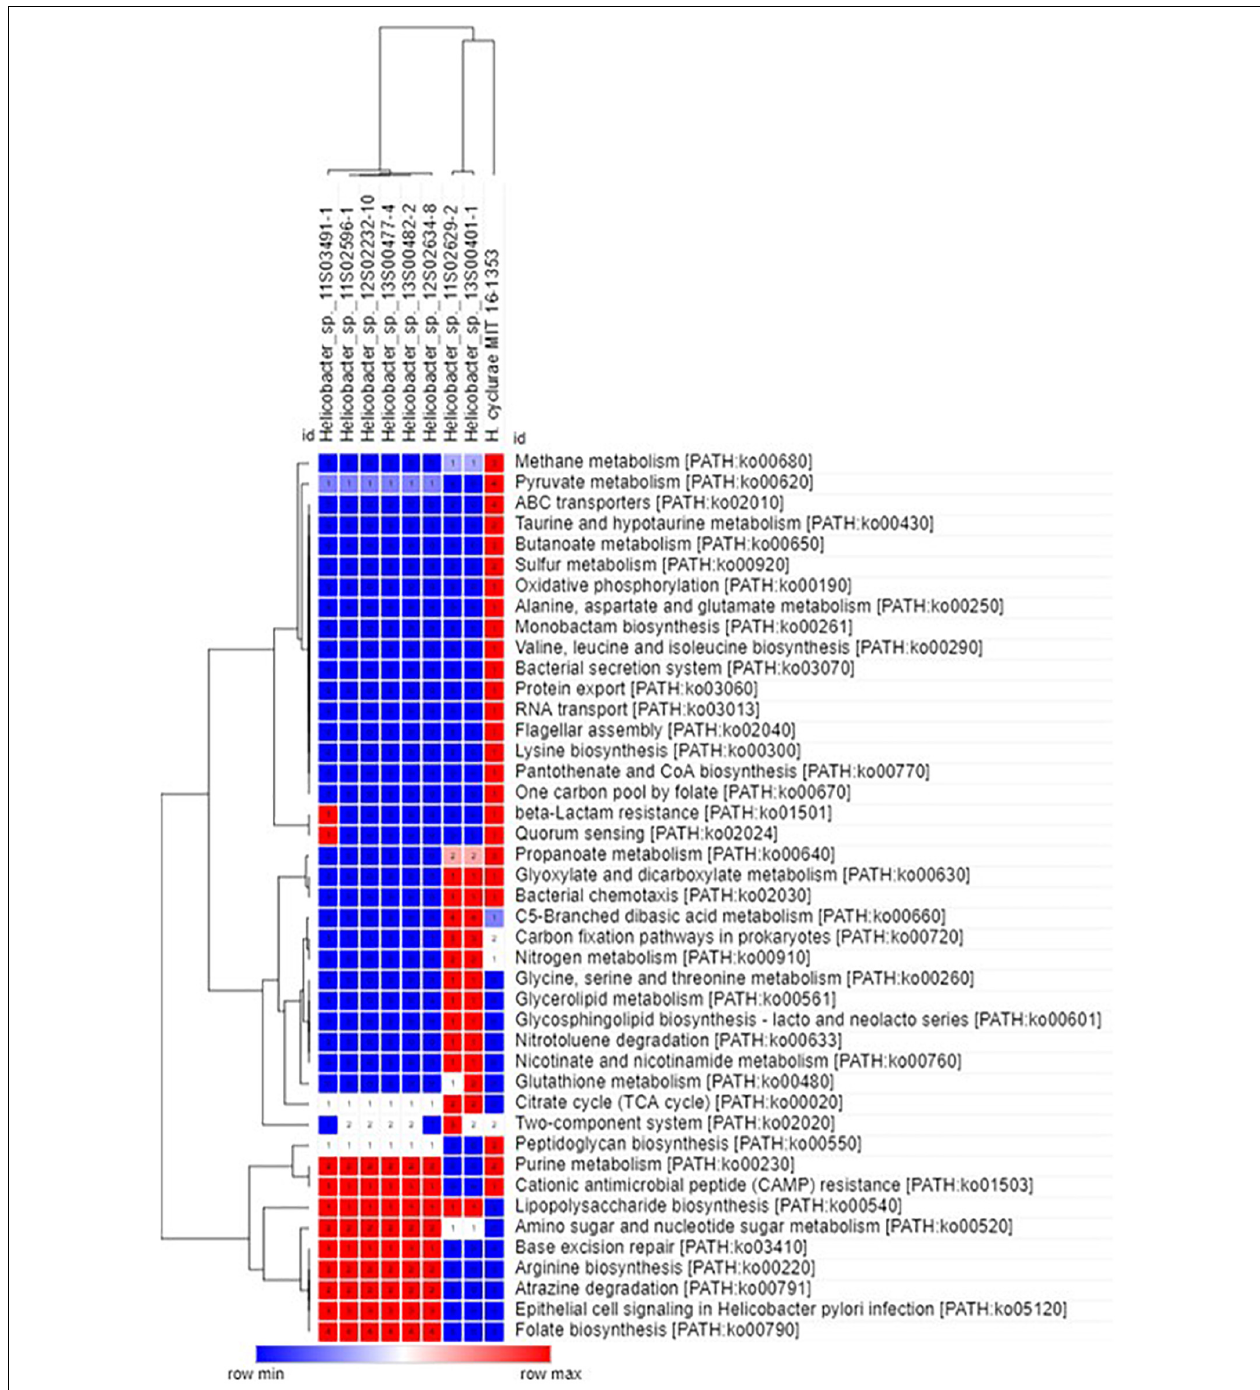
FIGURE 4 | Hierarchal clustering heatmap of unique orthogroups and associated KEGG metabolic/functional pathways from Helicobacter species isolated from reptilian hosts.